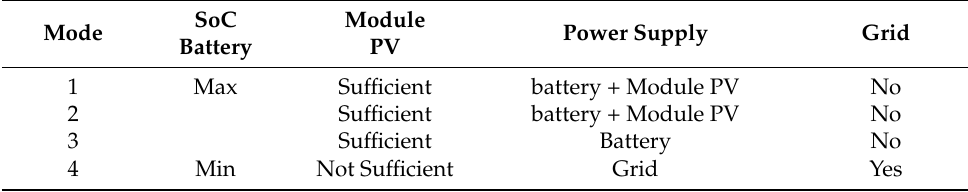
Table 1. Energy Flow Management Operating